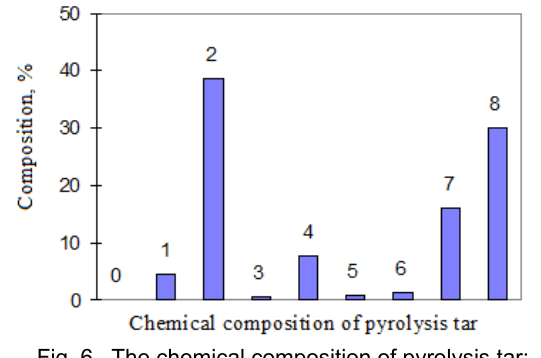
Fig. 7. SEC profiles of casein pyrolysis tar on (a) Mixed-A Fig. 6. The chemical composition of pyrolysis tar; column. Detection by UV-A at five wavelengths 1-280 nm, 1-free carbons; 2-organic bases; 3-organic acids; 2-300 nm, 3-350 nm, 4-370 nm and 5-450 4-phenols; 5-asphaltanes; 6-paraffins; 7-neutral oils; 8- preasphaltanes